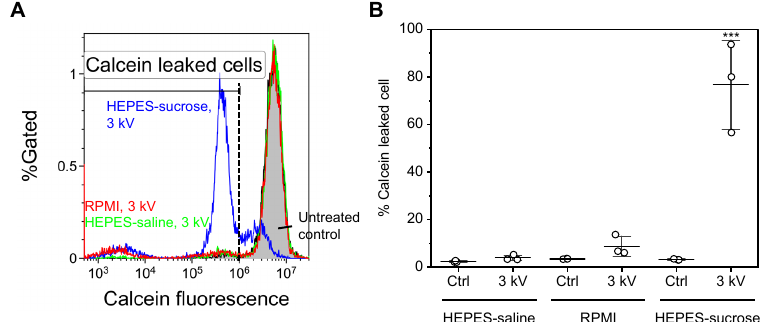
Figure 4. Measurement of the loss of intracellular molecules. ( A ) Representative flow cytometry histograms. The fluorescence intensity was determined for calcein. The dashed line indicates the threshold of the calcein-leaked cells. ( B ) The population of calcein-leaked cells after short-circuiting using different electroporation media, as determined using flow cytometry. Data are expressed as the mean ± SD of three independent measurements. Statistical significance was determined using one-way ANOVA followed by Tukey’s multiple comparison tests, ∗∗∗ p < 0.001 vs. all the other